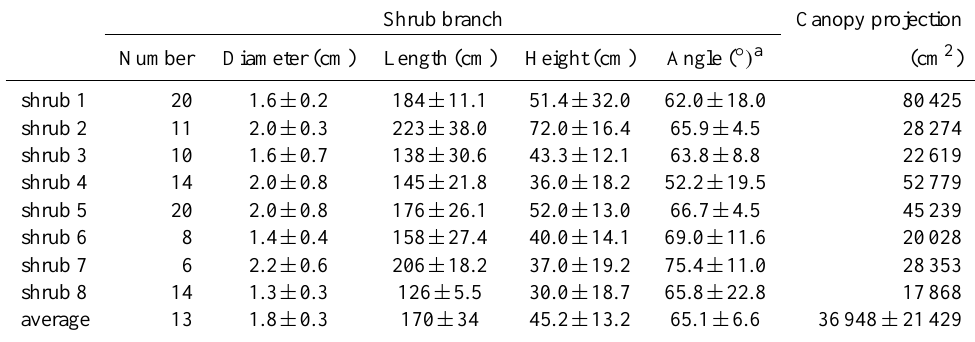
Table 1. Descriptive statistics (mean ± standard deviation) of branches and canopy projection of the C. corshinskii shrubs used in the experiments.